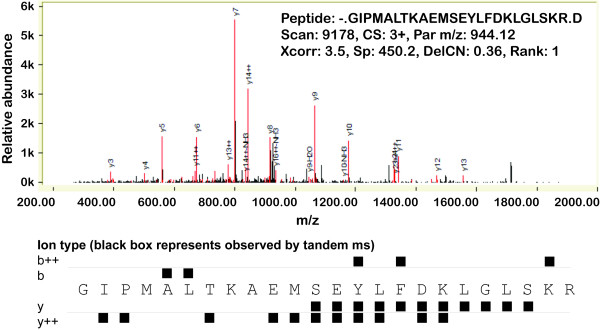
Validation of mass spectral evidence. Annotated experimental MS/MS spectra of the peptide "GIEPMALTKAEMSEYLFDKLGLSKR" with the fragmentation ladder below.